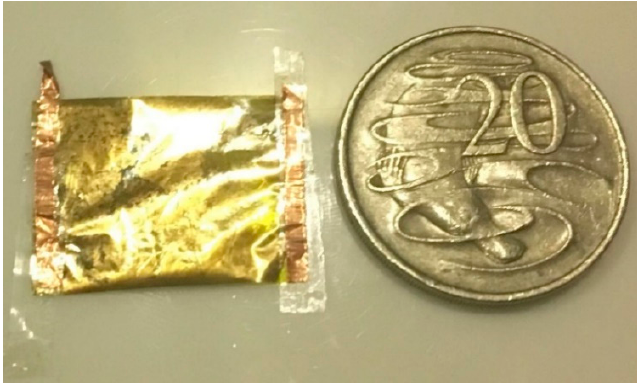
Figure 4. Comparison of the size of the finished sample with an AUD 20 cents.